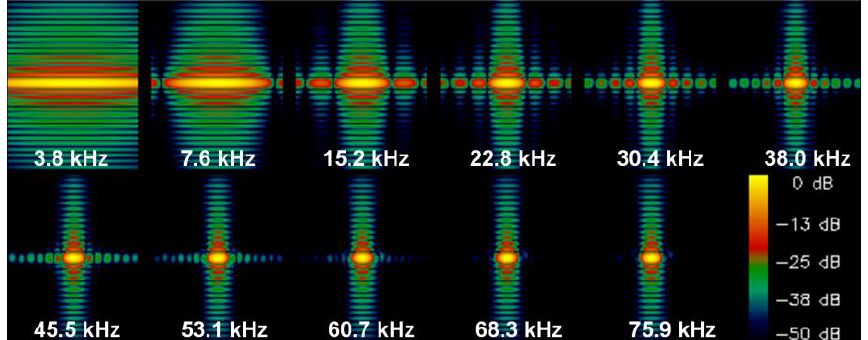
Figure 11. Corner reflector measurements in a TerraSAR-X wrapped staring spotlight image.